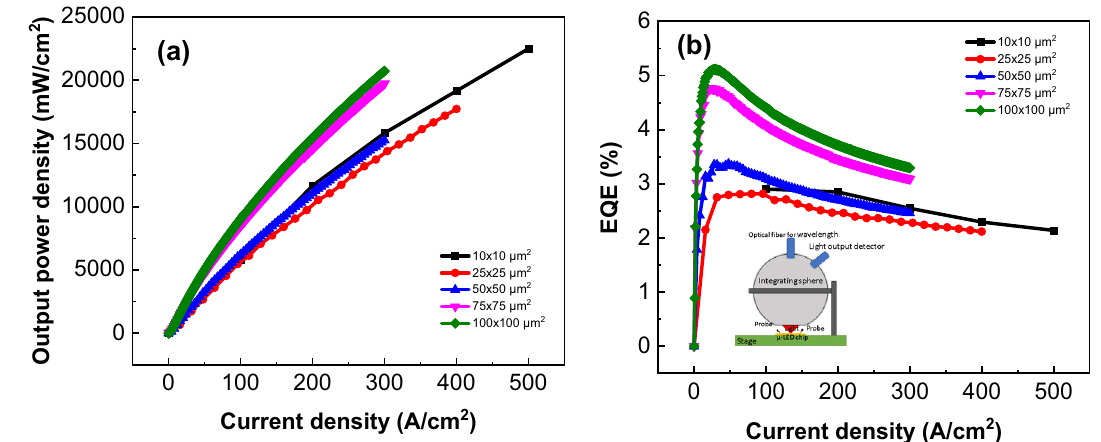
Figure 2. ( a ) Optical output power densities and ( b ) EQE as function of injection current densities for all chip size μ-LEDs. The setup of on-wafer EQE measurement shown in the inset of ( b